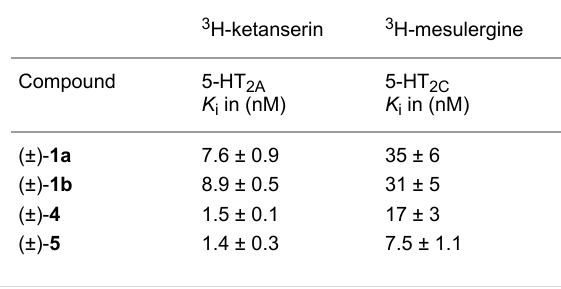
Table 1: Affinity values ( K i in nM) at human 5-HT 2A and 5-HT 2C recep- tors. All values represent mean and SEM from at least three inde- pendent experiments.